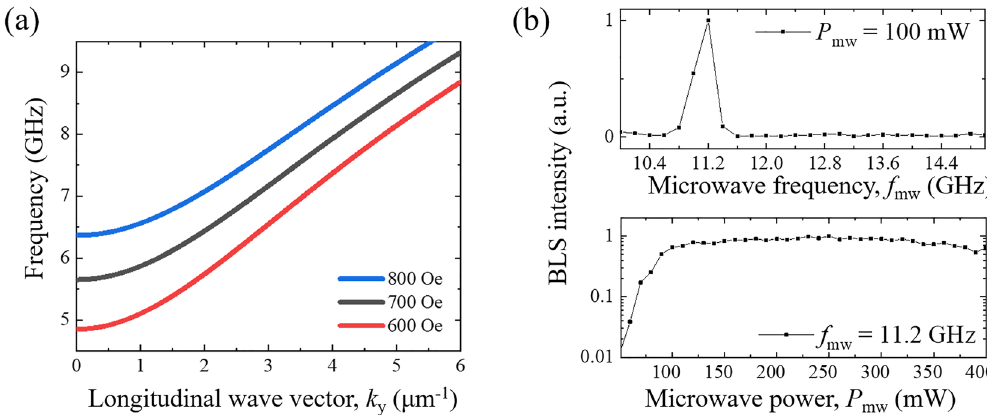
Figure 2. (a) Dispersion relation for the spin wave of the n = 1 width mode for fixed magnetic fields of H = 600, 700, and 800 Oe. (b) Normalized BLS intensity at H = 700 Oe as a function of microwave frequency ( f mw ) for a fixed microwave pumping power of P mw = 100 mW (upper panel) and as a function of P mw for a fixed f mw = 11.2 GHz (lower panel). The BLS intensity is observed at a frequency of f sw = 5.6 GHz, i.e., f sw = f sw